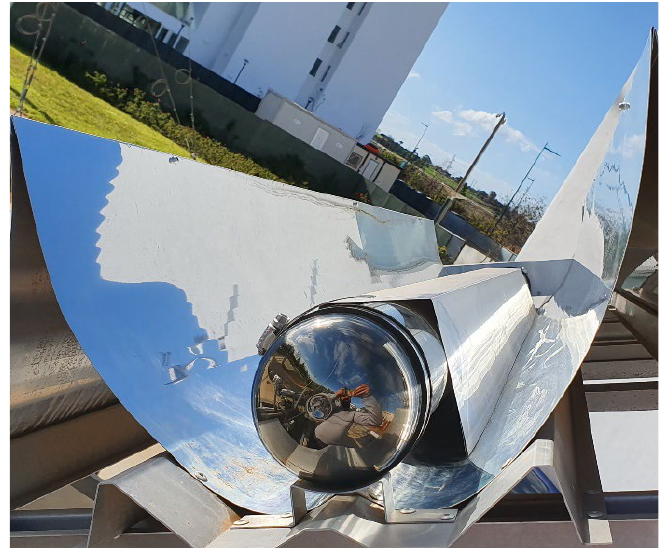
Figure 3. XCPC collector evacuated tube.